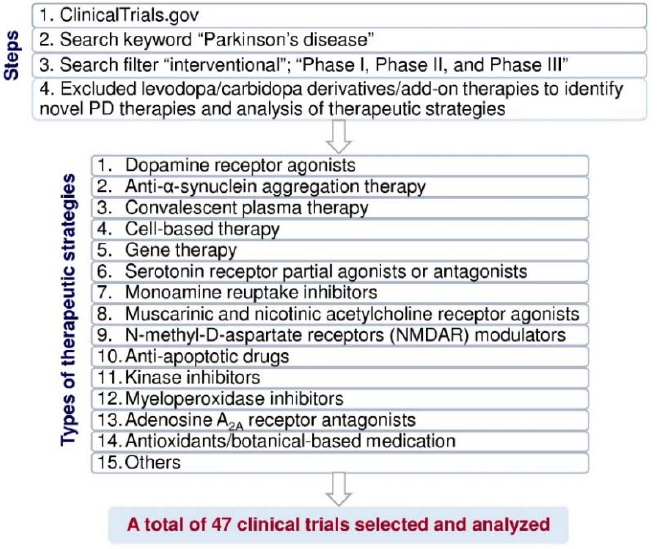
Figure 2. Flow diagram of the method used to select and analyze the clinical trial data for PD treatment from ClinicalTrials.gov (https://clinicaltrials.gov, accessed on 16 June 2021).